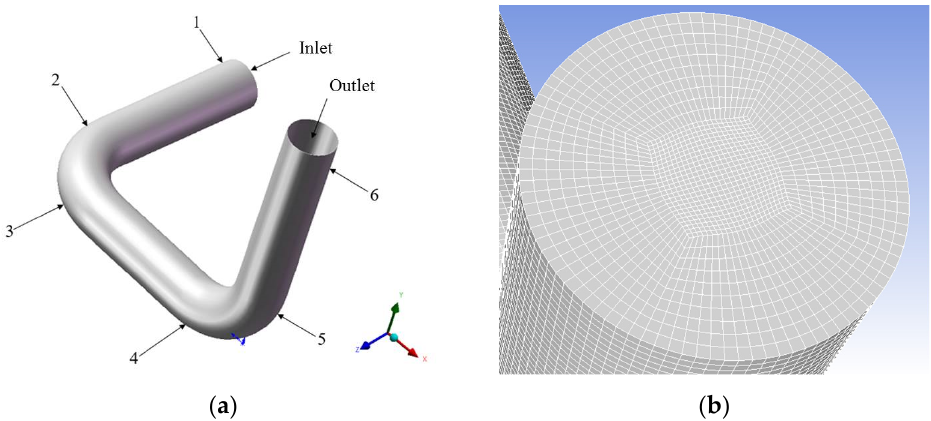
Figure 1. ( a ) The geometry of three-dimensional circular pipe in which the nanofluids flow under a uniform magnetic field. 1 is inlet and 6 is outlet, 2, 3, 4, and 5 are the faces in the pipe. ( b ) Grid distribution on the outlet.